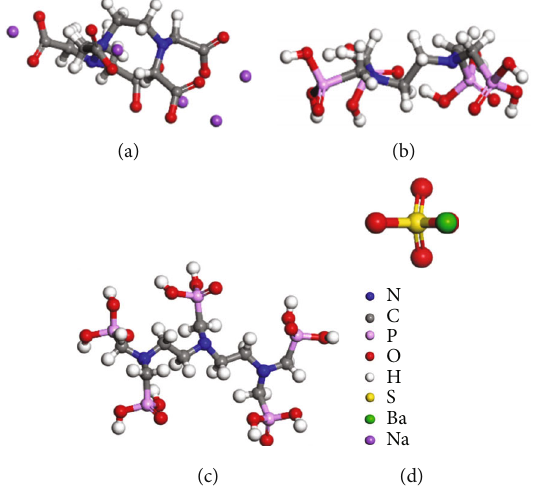
Figure 4: Molecular models of inhibitors and mineral scale (a) DTPA-5Na, (b) EDTMPS, (c) DTPMP, and (d) BaSO